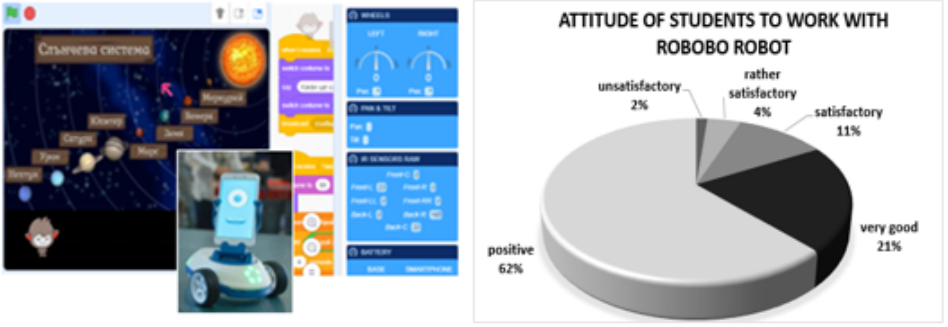
Figure 18. Game-based learning with ROBOBO in the experimental STEM center.